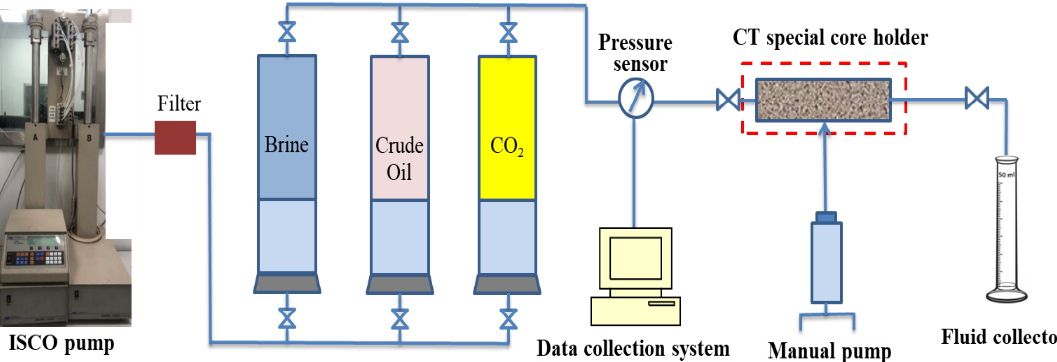
Figure 1. Core displacement and online CT scanning device.